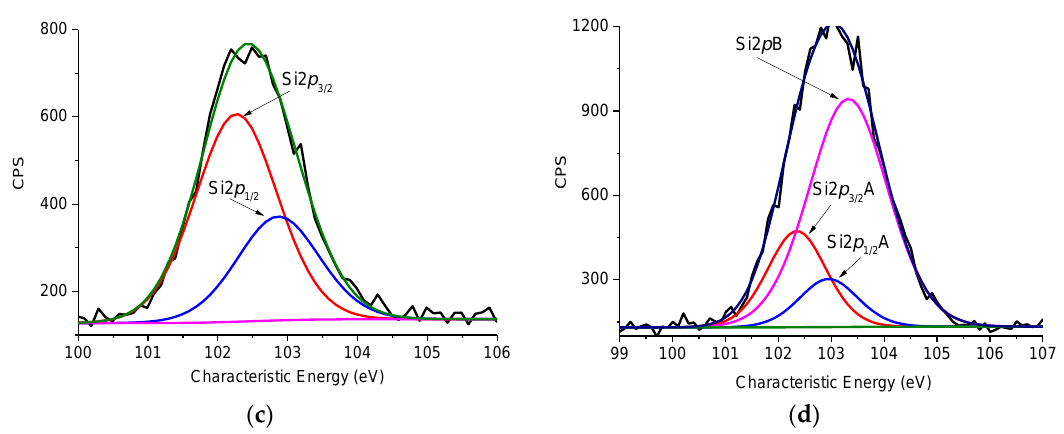
Figure 5. X-Ray Photoelectron Spectroscopy (XPS) spectra of the N1 s (a,b) and Si2 p (c,d) levels for the CFBL – Mannich (a,c) and CFBL – silica (b,d) samples.